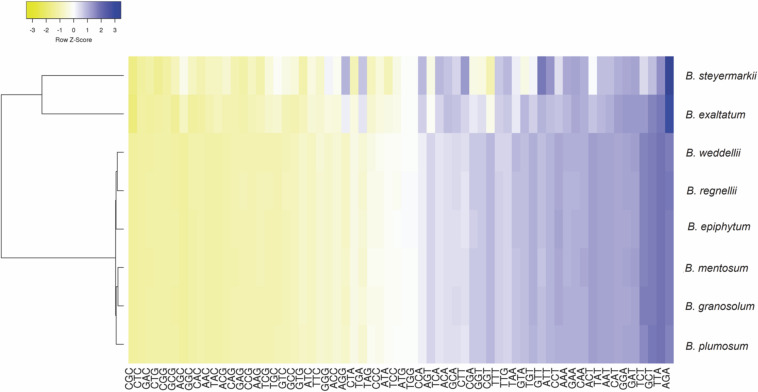
Relative synonymous codon usage ratio (RSCU) of protein-coding genes of the eight Bulbophyllum plastid genomes. Blue indicates a high RSCU ratio, and yellow indicates low.